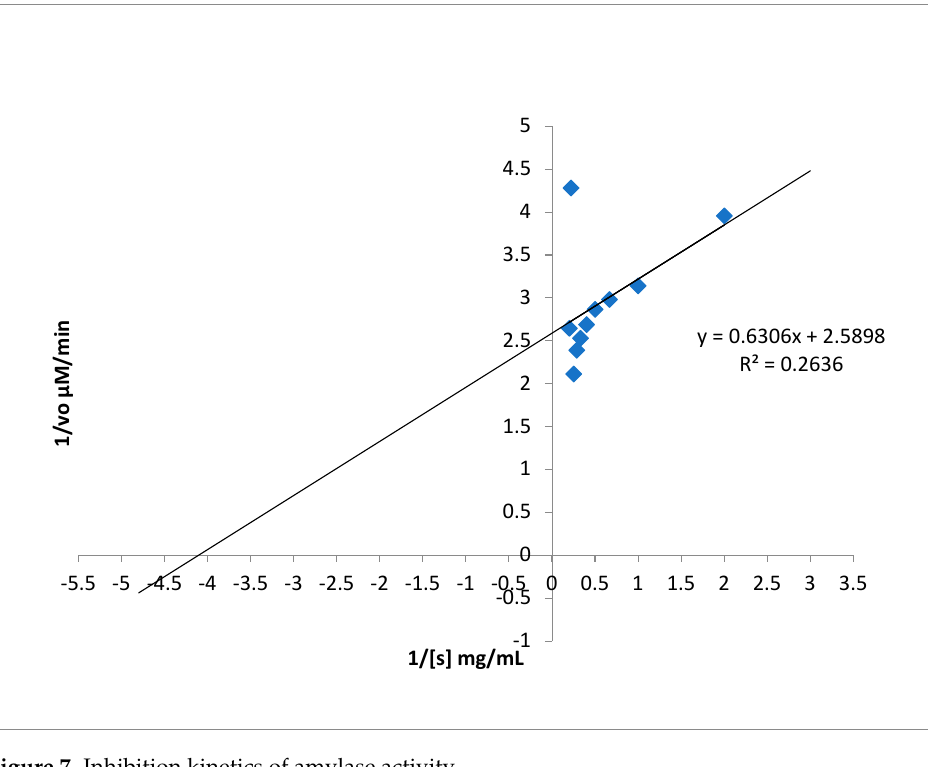
Figure 7. Inhibition kinetics of amylase activity.